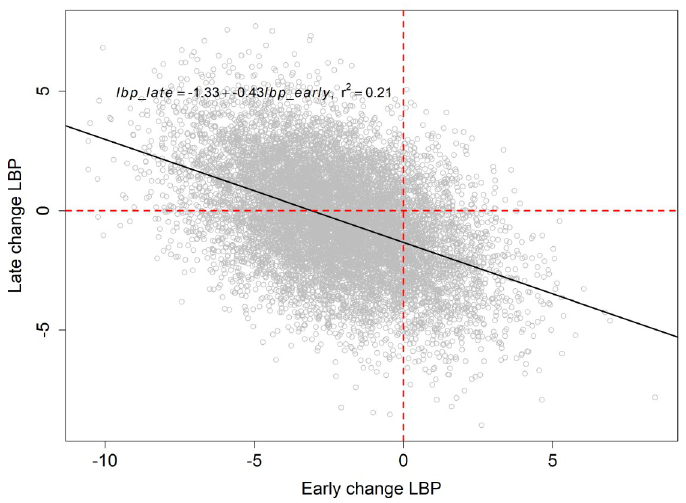
Fig 5. Posterior samples (104) of the relationship between an early change in disability against an early change in depressive symptoms, with associated linear relationship.